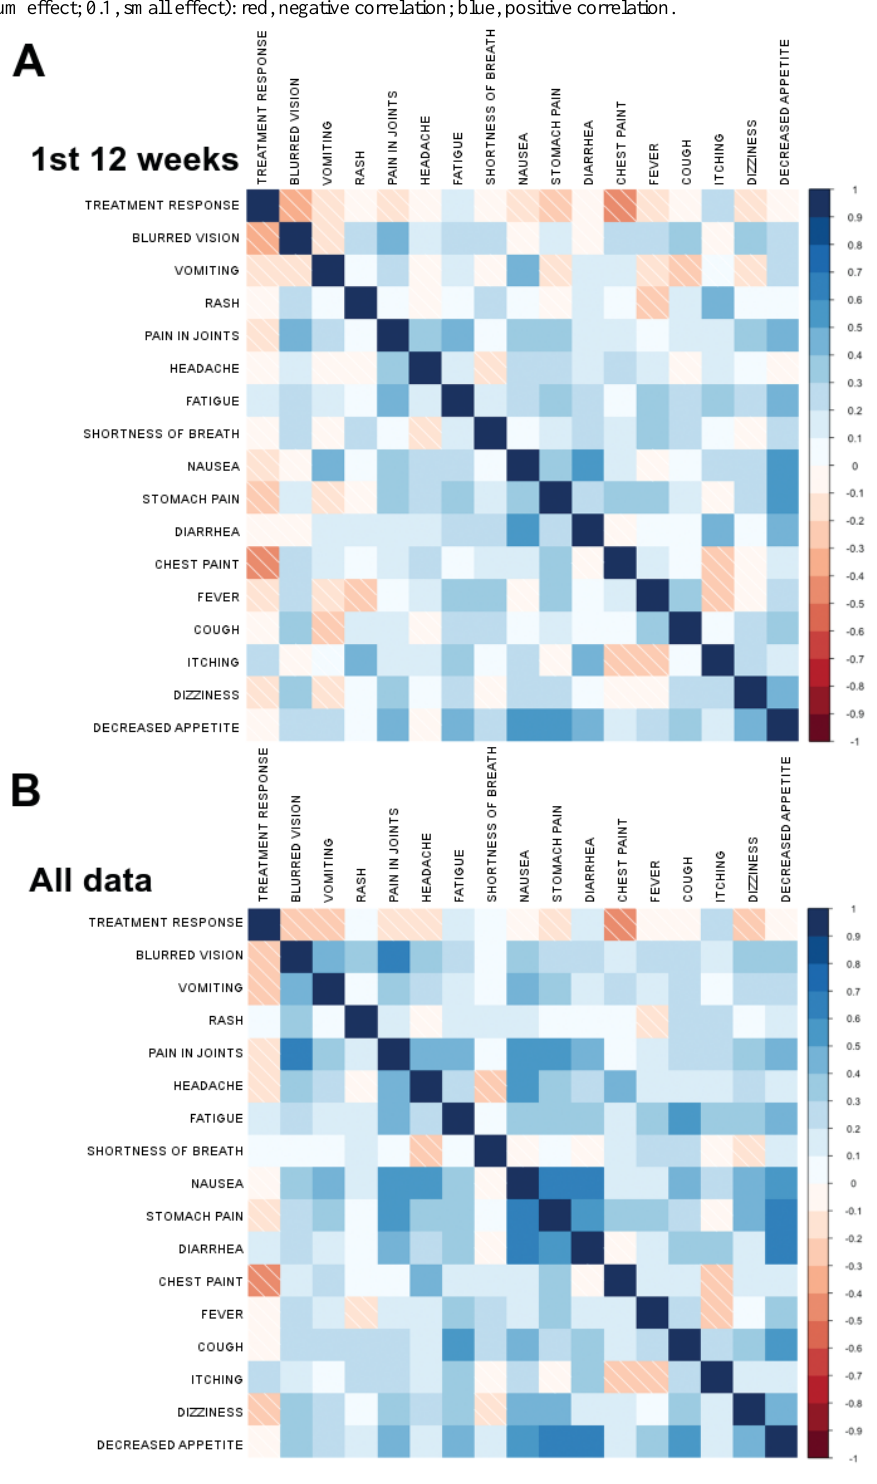
data, Figure 2B) and medium correlations between PD and chest pain (–0.41 for the first 12 weeks, Figure 2A; –0.47 for all data, Figure 2B). We further analyzed symptom progression and severity for itching and chest pain. During the first 12 weeks, 15-23% of the patients with clinical benefit reported itching, while the rate was much lower for patients with PD